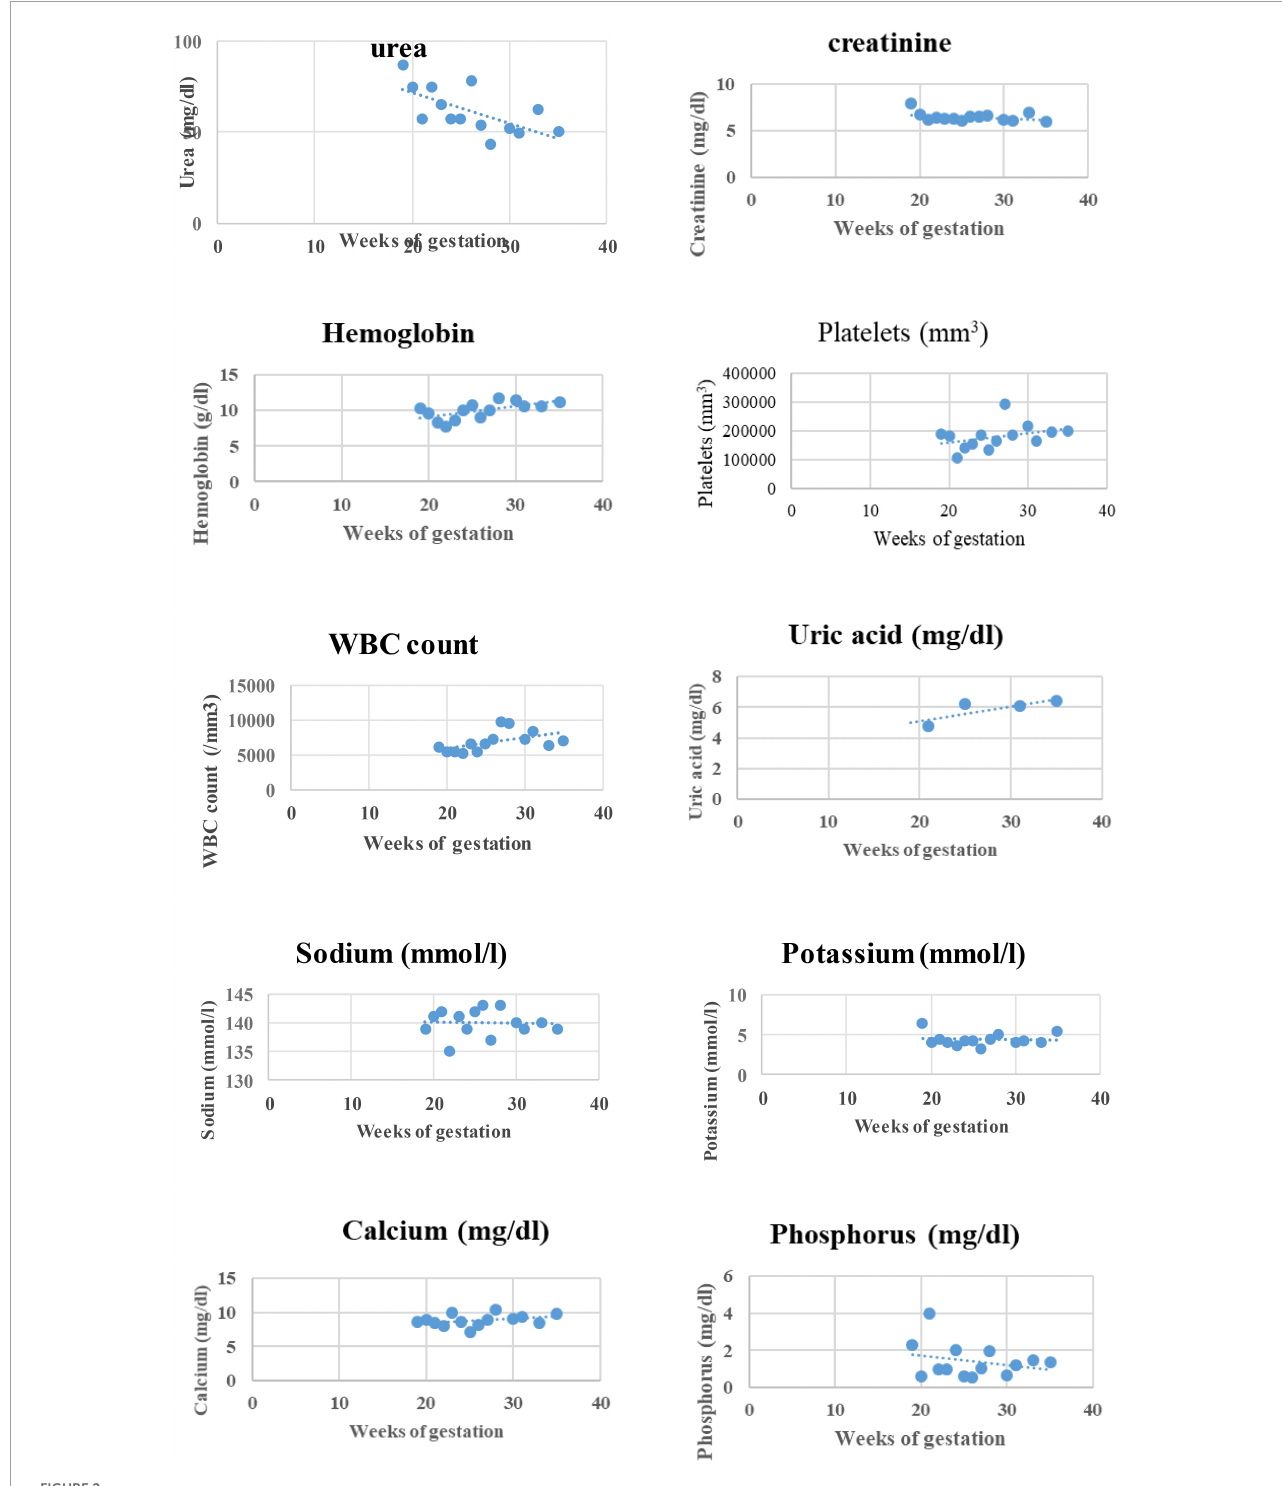
FIGURE2 Evolution of weekly biochemical parameters with gestational